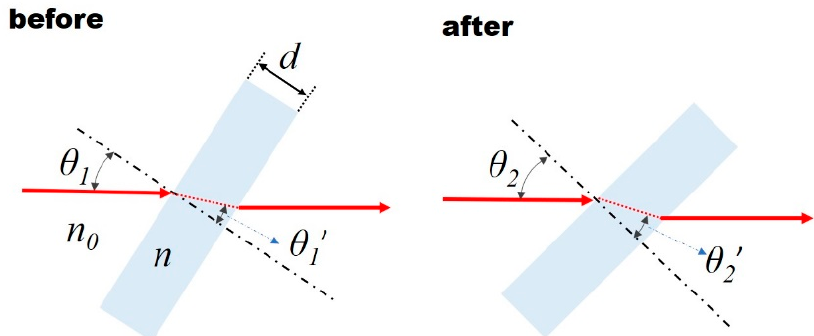
Figure 2. Schematic of phase modulation introduced by rotating a glass plate. IDFDHM uses an arbitrary micro-phase-shift modulation method [8] to achieve de- structive interference between the object light and reference light. The main method is to change the phase of the reference light to achieve destructive interference by using phase shift technology. Under the condition of destructive interference, IDFDHM captures the image of the dark field and reconstructs the object information. Scattering is a major problem that degrades the fidelity of an image. It is caused